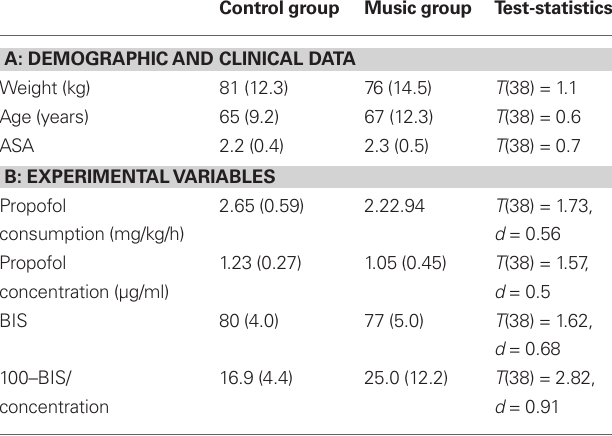
Table 1 | A: Baseline demographic and clinical characteristics. Means (with SD in parentheses) of weight (in years), age (in kg), and ASA scores, separately for each group. The outermost right column shows the T -values of independent-samples T -tests. B : Experimental variables related to the sedation of the subjects. Means (with SD in parentheses) of propofol consumption, propofol concentration, bispectral index (BIS), and BIS-value relative to propofol concentration (100–BIS-value/concentration), separately for each